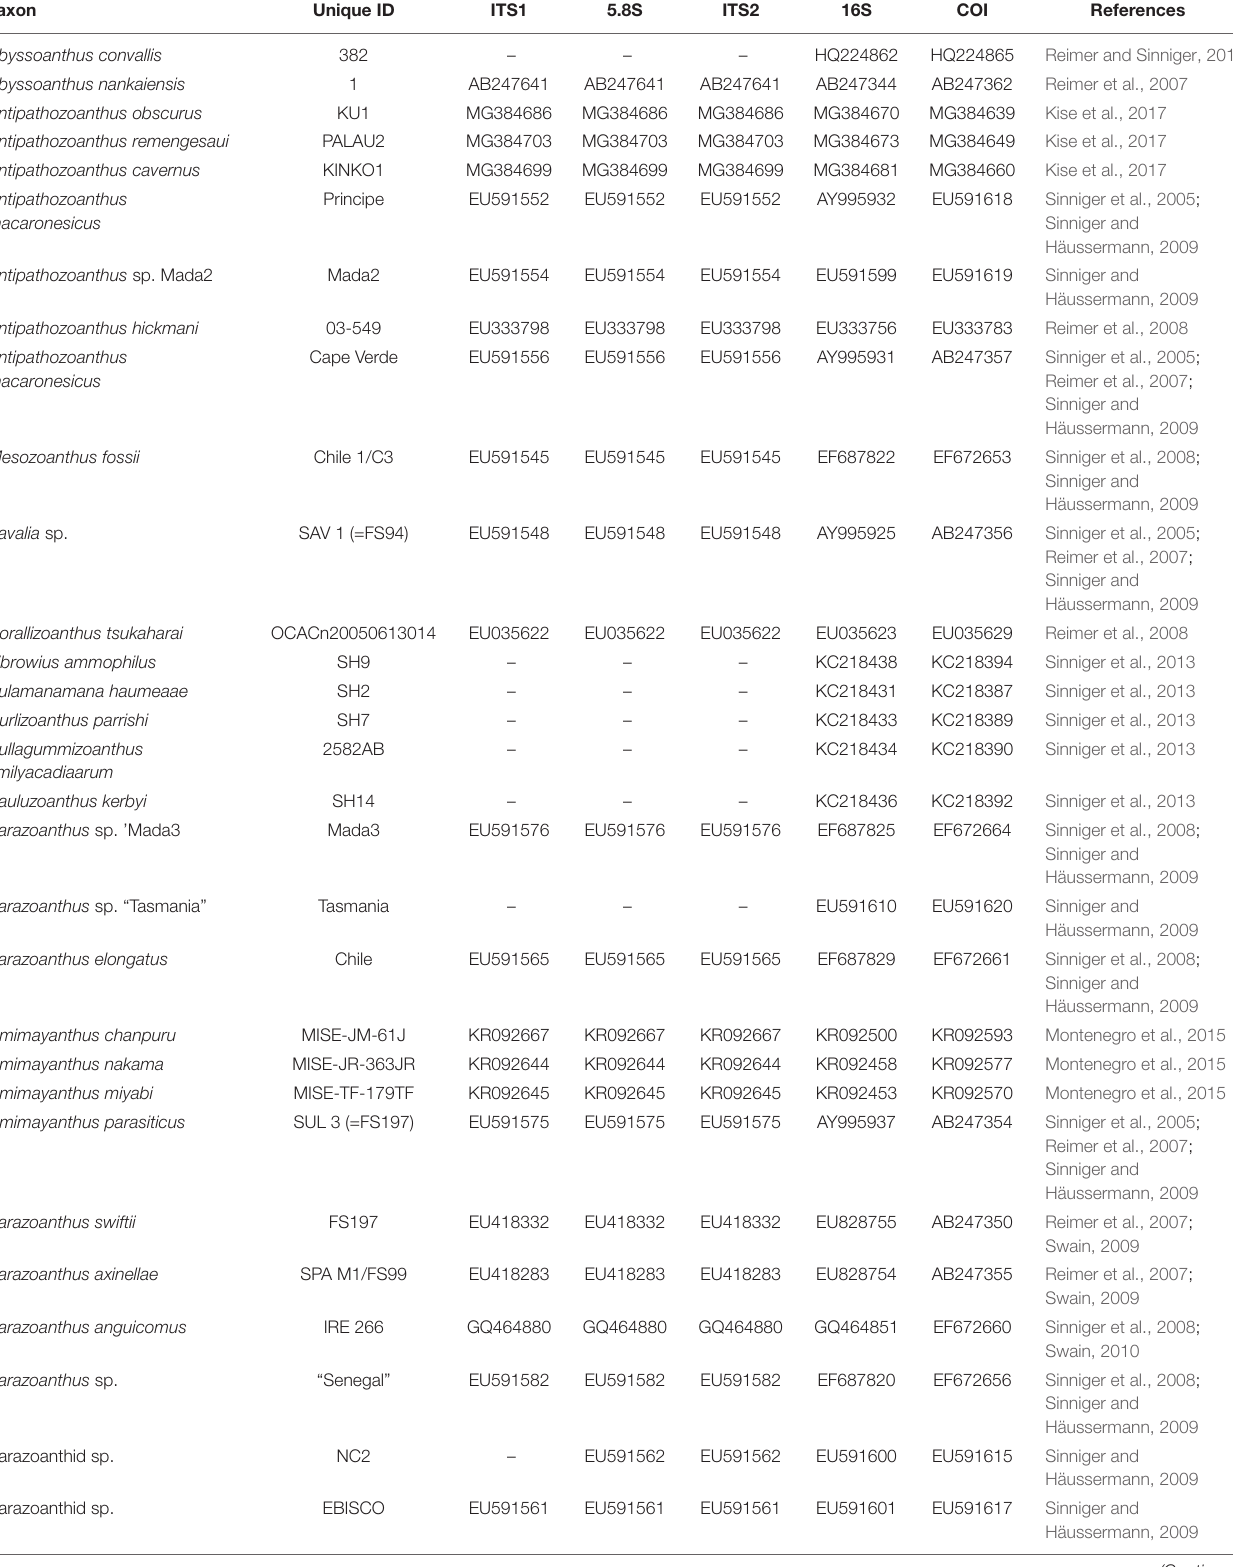
TABLE 2 | List of sequences used in phylogenetic analyses in this